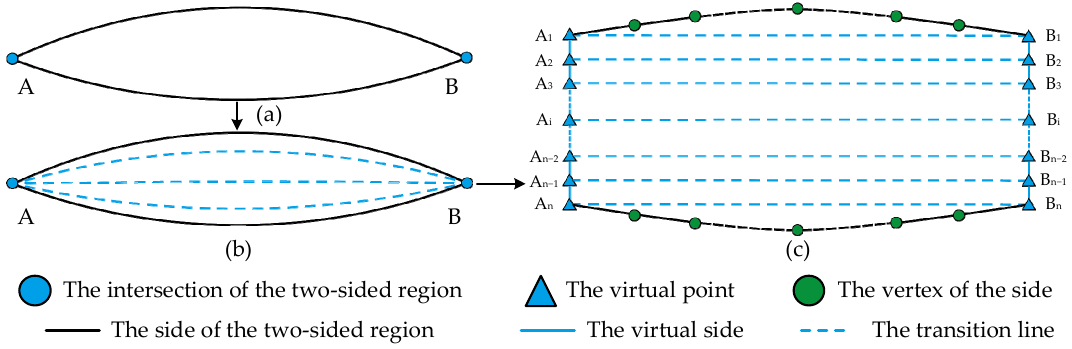
Figure 7. Schematic diagram of the two-sided region processing: ( a ) the original two-sided region; ( b , c ) the process and result of adding virtual sides and virtual points. The black dotted lines are omitted lines.